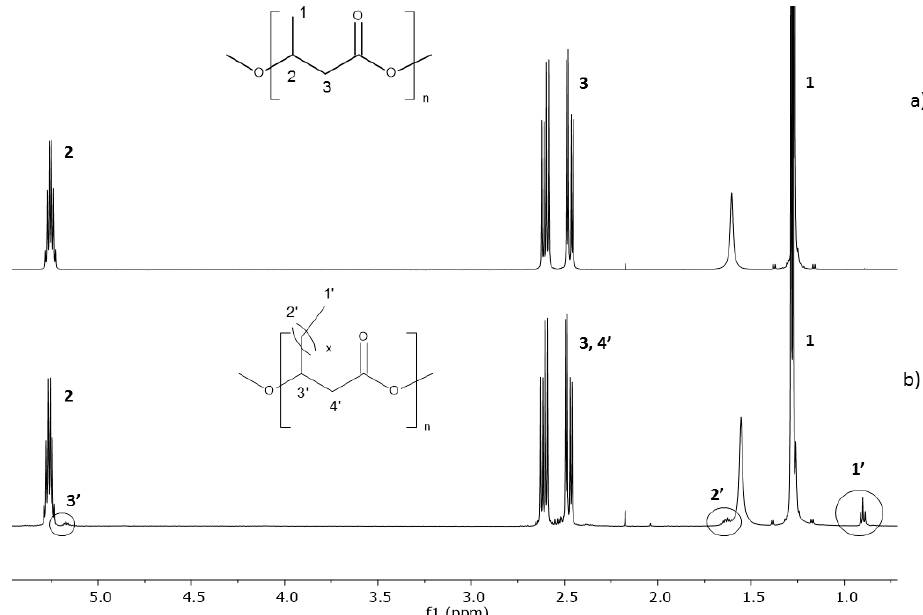
Figure 3. 1 H-NMR spectra of the polyesters obtained via fermentation of R. eutropha H16 with the use of ( a ) TSB; and ( b ) TSB/O-PEW as an additional carbon sources.